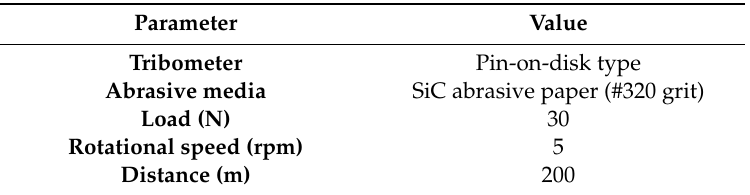
Table 4. Tribotest